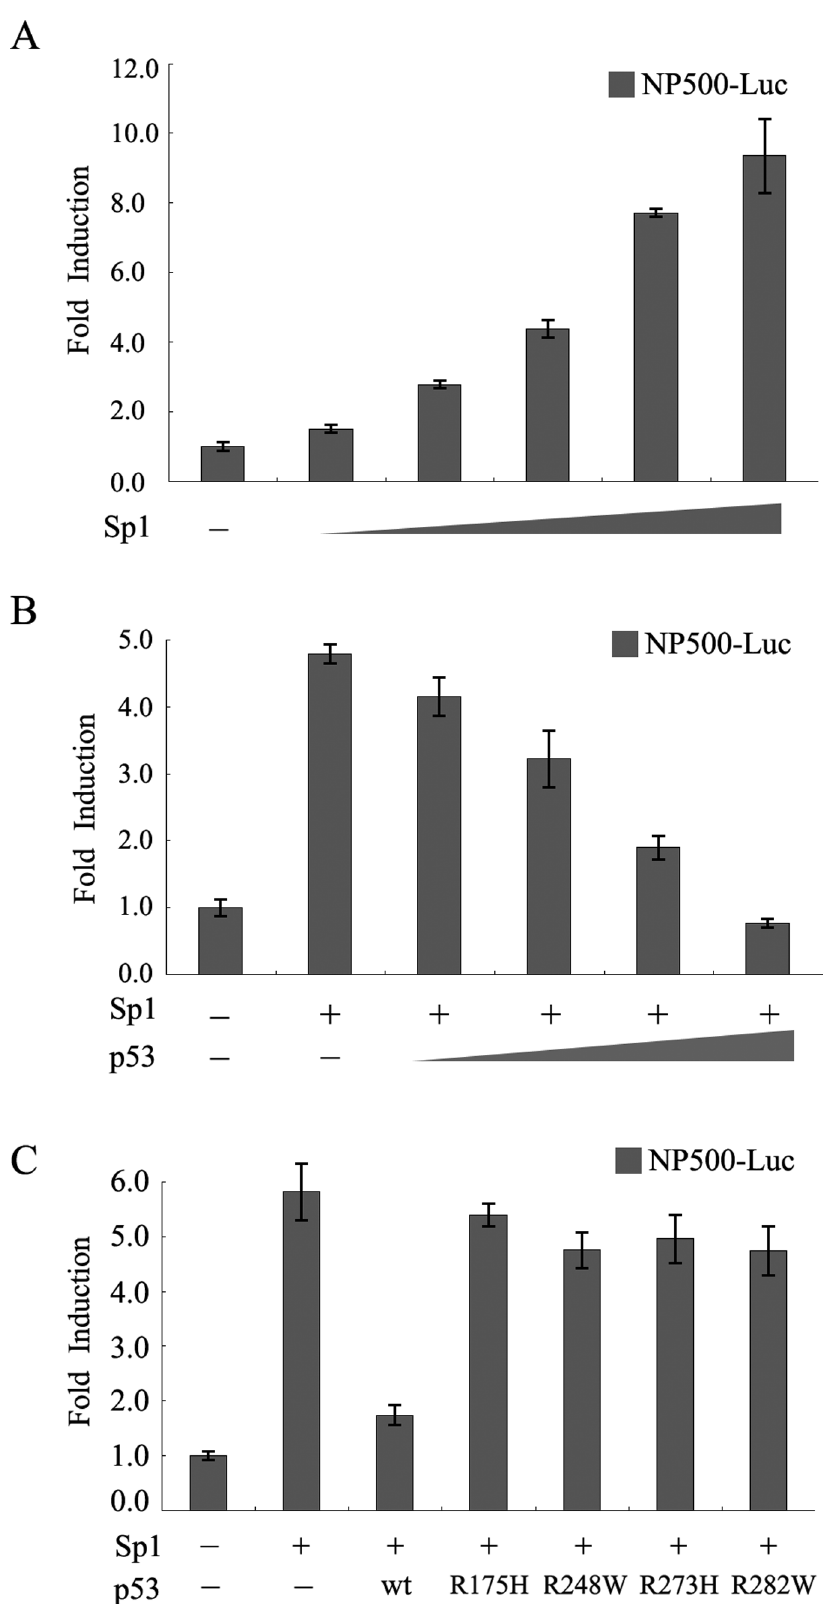
Figure 4. p53 inhibits Sp1-mediated activation of the RLIM promoter. ( A ) Sp1 activated the RLIM promoter activity. H1299 cells were cotransfected with 100 ng of NP500-Luc with either 160 ng pCMV empty vector as control or increasing amounts (0, 10, 20, 40, 80 and 160 ng) of